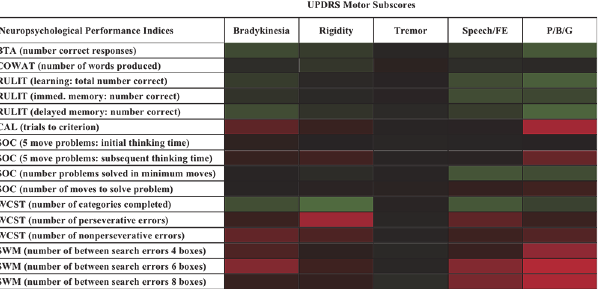
Fig 1. Heat map showing the relationships between cognitive test performance (based on correlation coefficients) and subscores from the Unified Parkinson ’ s Disease Rating Scale (UPDRS) motor scales. Green denotes a significant negative correlation, red denotes a significant positive correlation and black denotes no significant correlation. The intensity of the color reflects the strength of the